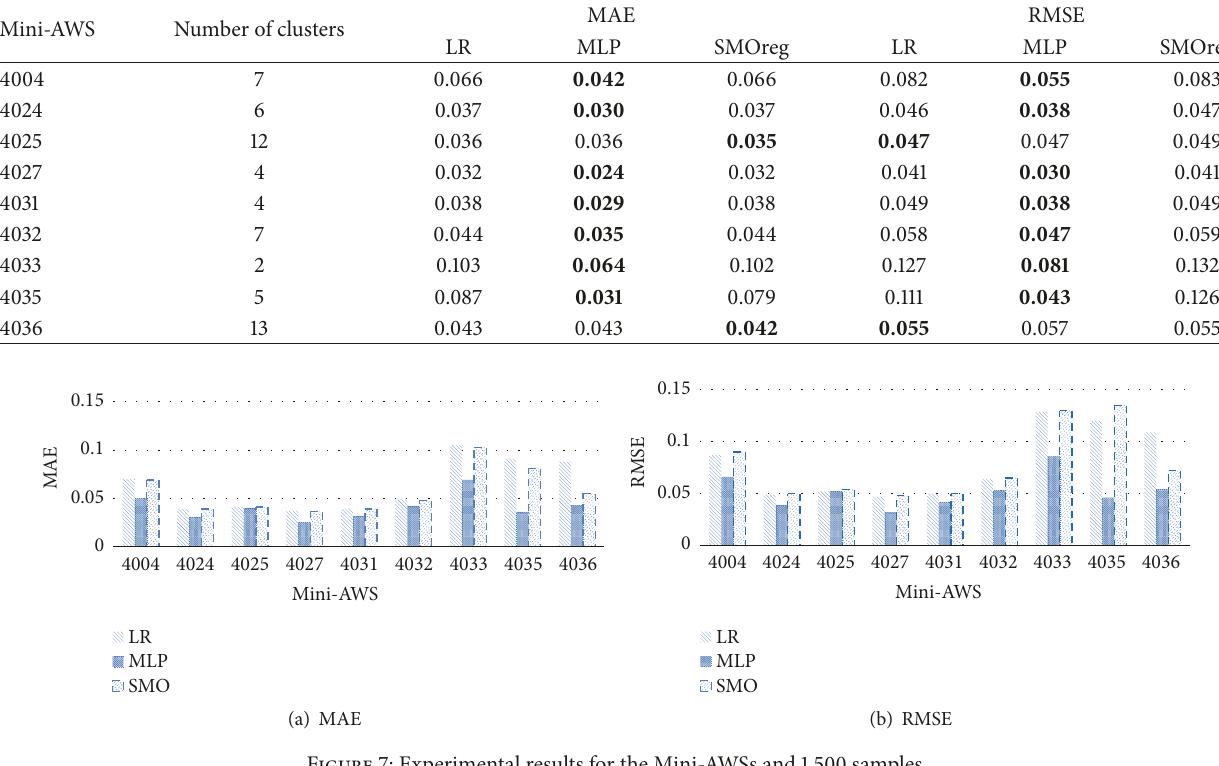
Figure 7: Experimental results for the Mini-AWSs and 1,500 samples.